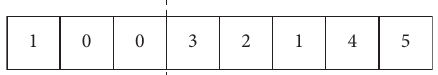
Figure 1: Representation of the chromosome.